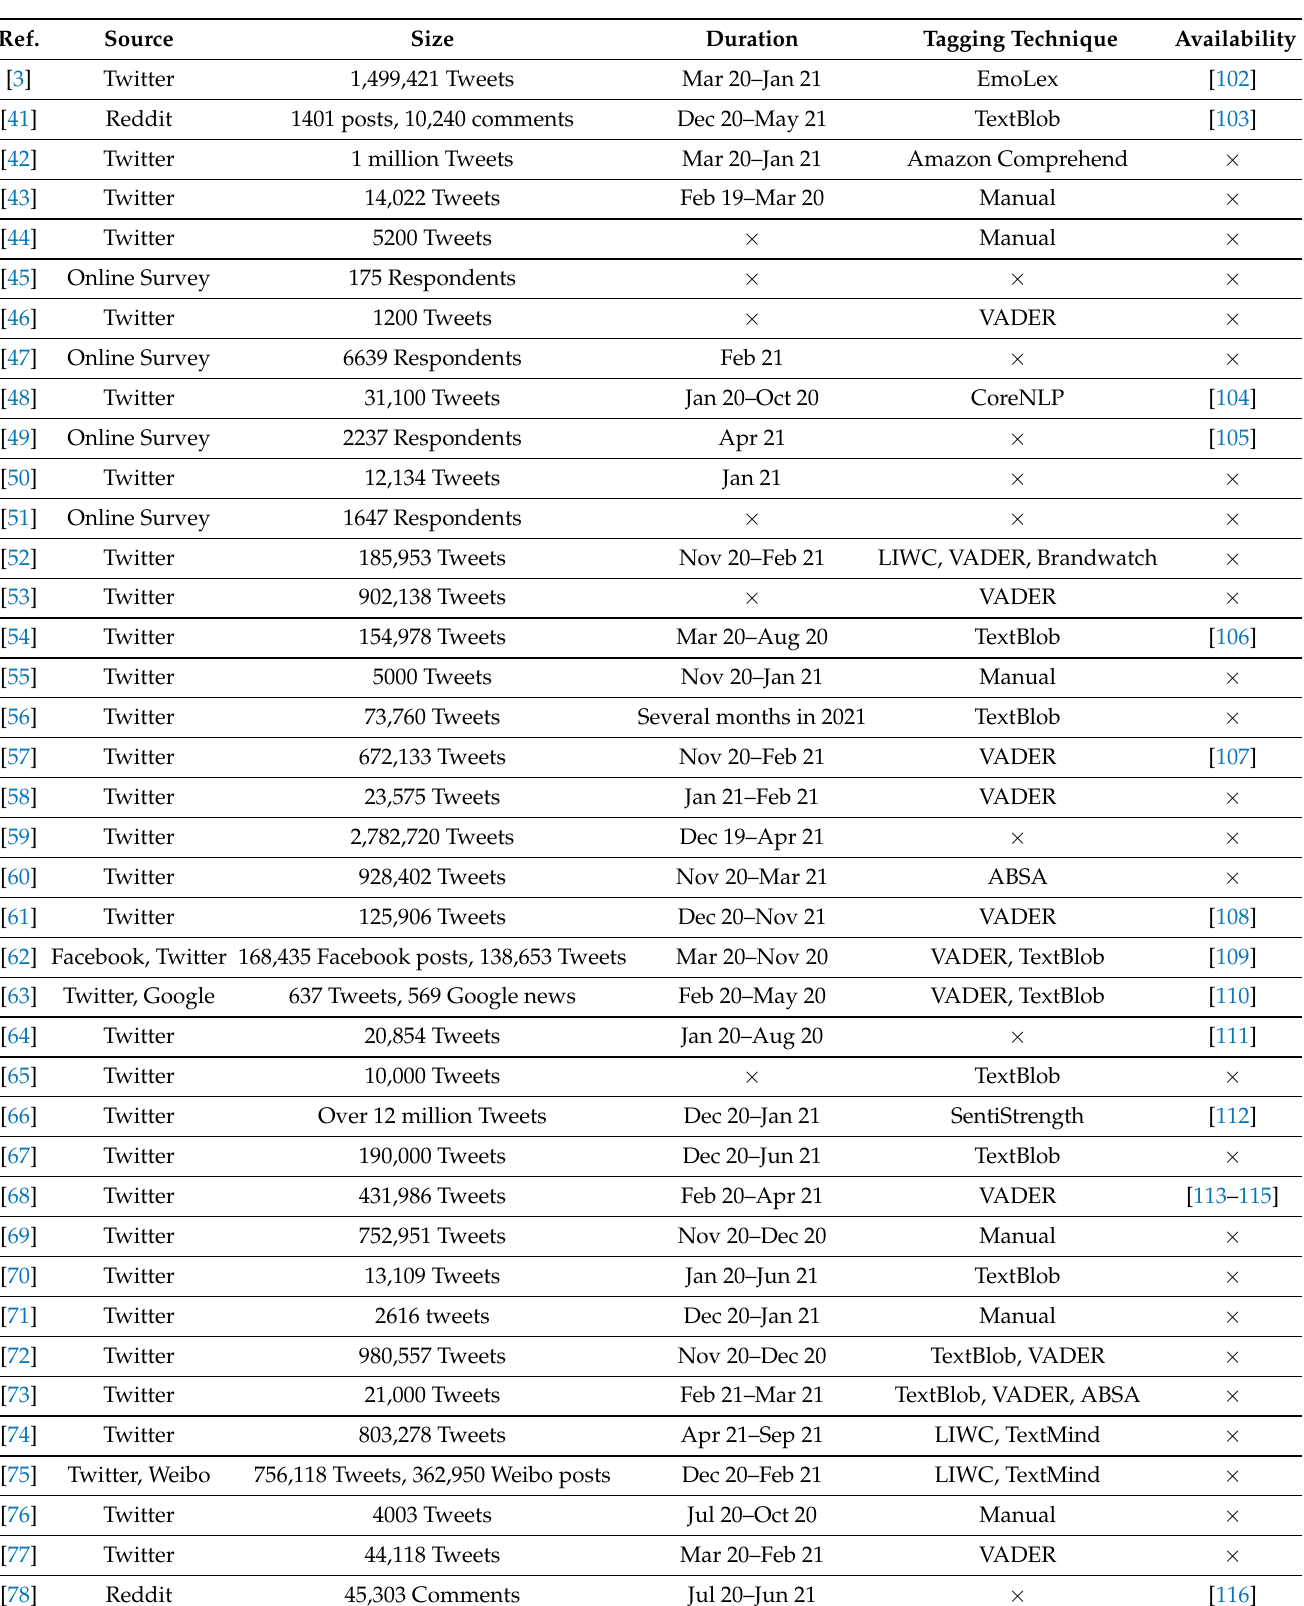
Table 5. Characteristics of datasets employed to investigate the public’s opinion of COVID-19 vaccines in the reviewed studies